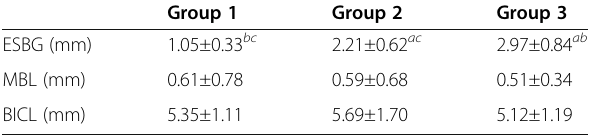
P value calculated by the one-way ANOVA The characters a , b , c indicated significant difference found when comparing to groups 1, 2, and 3 respectively under Games-Howell test (overall P